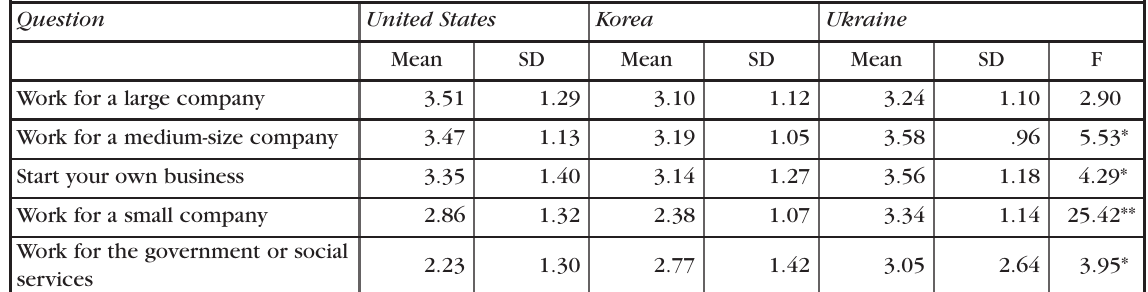
Table 5. New Venture versus Organizational Career Expectations